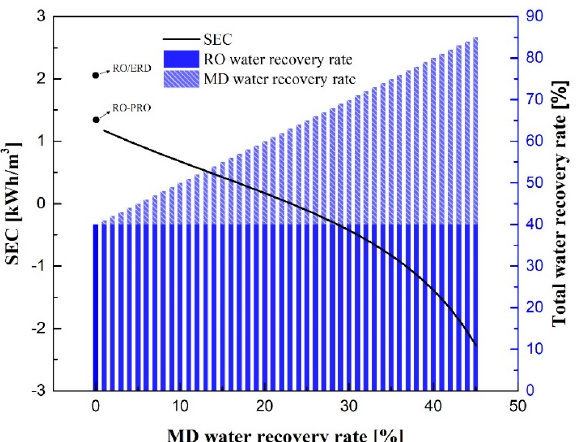
Figure 11. SEC of the RO-MD-PRO process at various MD water recovery rates and total water recovery rates.